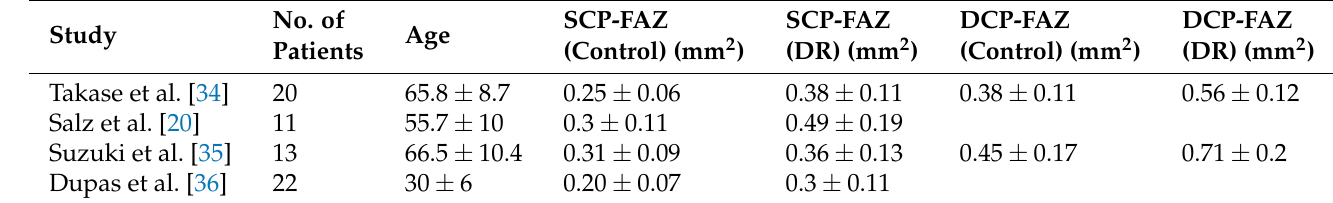
Table 1. Average areas of FAZ in both normal and DR